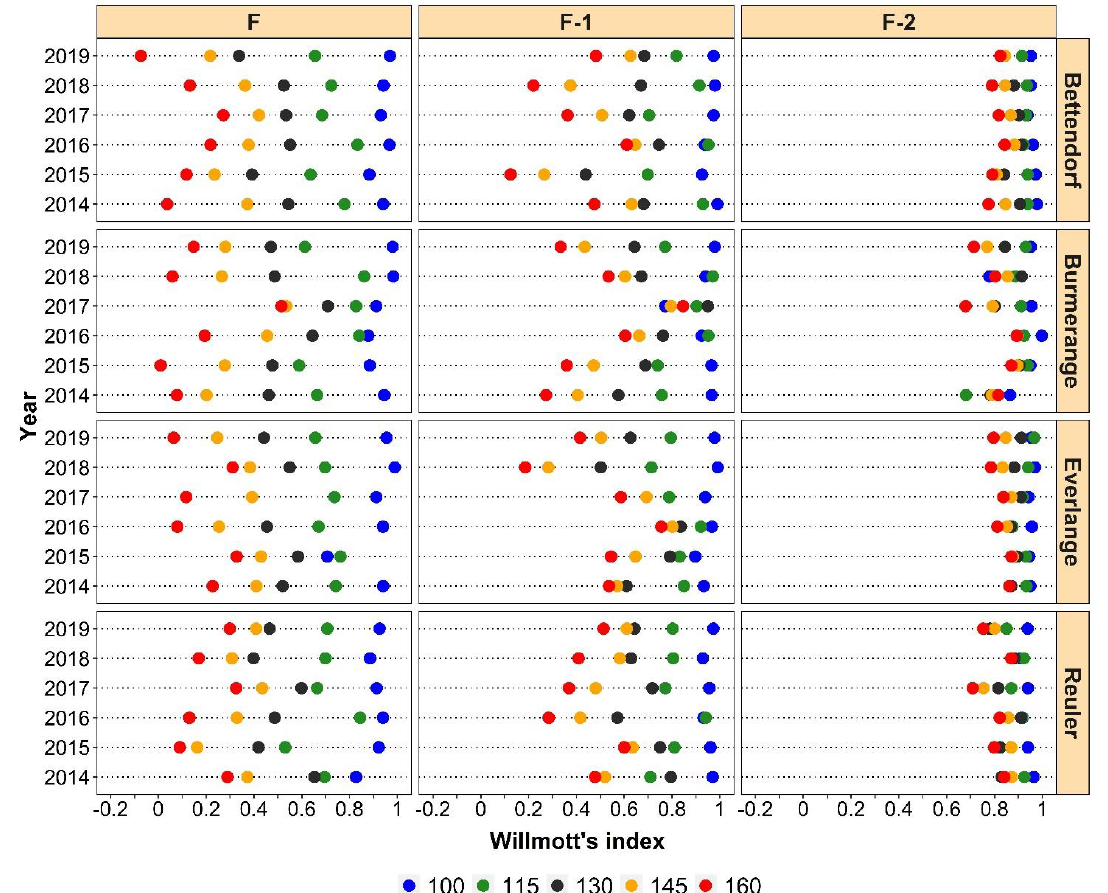
Figure 4. Comparisons of the Willmott’s index values according to the phyllotherms (100, 115, 130, 145 and 160 °Cd) used for predicting the emergence of leaves F, F-1 and F-2 in winter wheat during the 2014–2019 cropping seasons at the different study sites in the Grand-Duchy of Luxembourg. F is the flag leaf. In all years only values for the cultivar Kerubino were used.